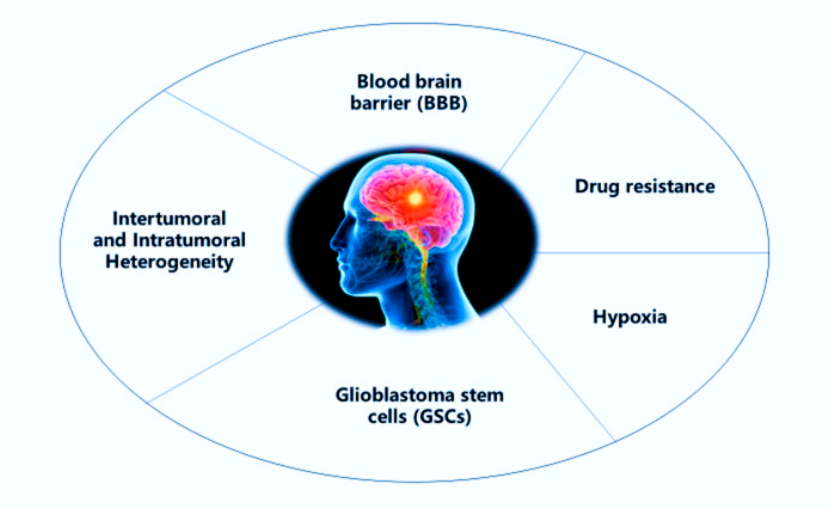
Figure 1. Scheme representing the major challenges in the treatment of glioblastoma multiforme (GBM)